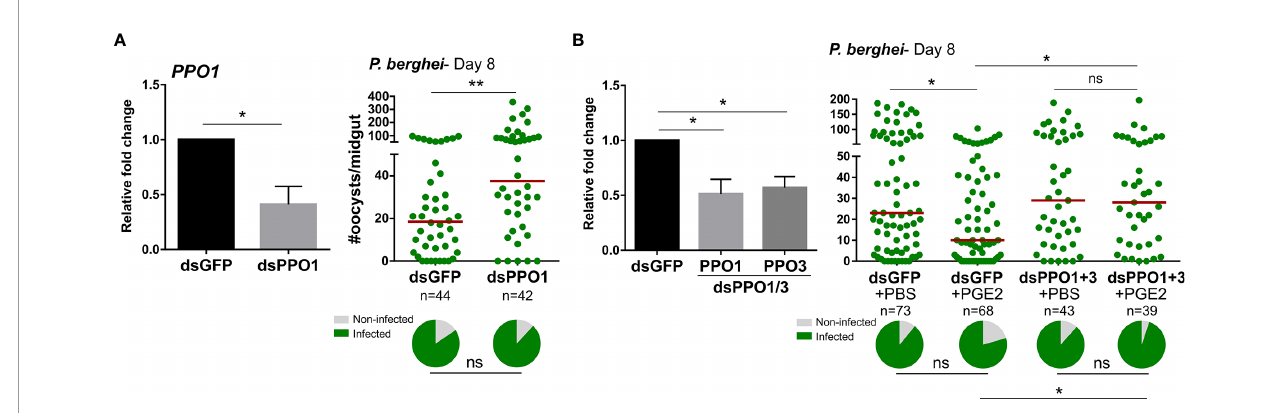
FIGURE 4 | Anti- Plasmodium effects of PGE2 priming are mediated by mosquito prophenoloxidases (PPOs). Signi fi cant reduction of PPO1 gene expression enhanced oocyst survival at 7 days post-infection (A) PPO1 gene expression was ef fi ciently reduced following RNAi, resulting in a signi fi cant increase in P. berghei oocyst survival when evaluated 8 days post-infection. To verify the role of mosquito PPOs in mediating PGE2 immune activation, PPO1 and PPO3 were co-silenced and then primed with either PBS (control) or PGE2 (B) . Following challenge with P. berghei , oocyst survival was examined 7 days post-infection. Data were analyzed by an unpaired t test to determine RNAi ef fi ciency and a Mann – Whitney test to assess oocyst survival using GraphPad Prism 7.0. Bars represent mean ± SE of three independent biological replicates. Median oocyst numbers from three or more independent biological replicates are indicated by the horizontal red line. The prevalence of infection (% infected/total) is depicted for mosquitoes under each experimental condition and examined by X 2 analysis to determine signi fi cance. Asterisks denote signi fi cance (* P < 0.05, ** P < 0.01); ns, not signi fi cant. n = number of individual mosquitoes